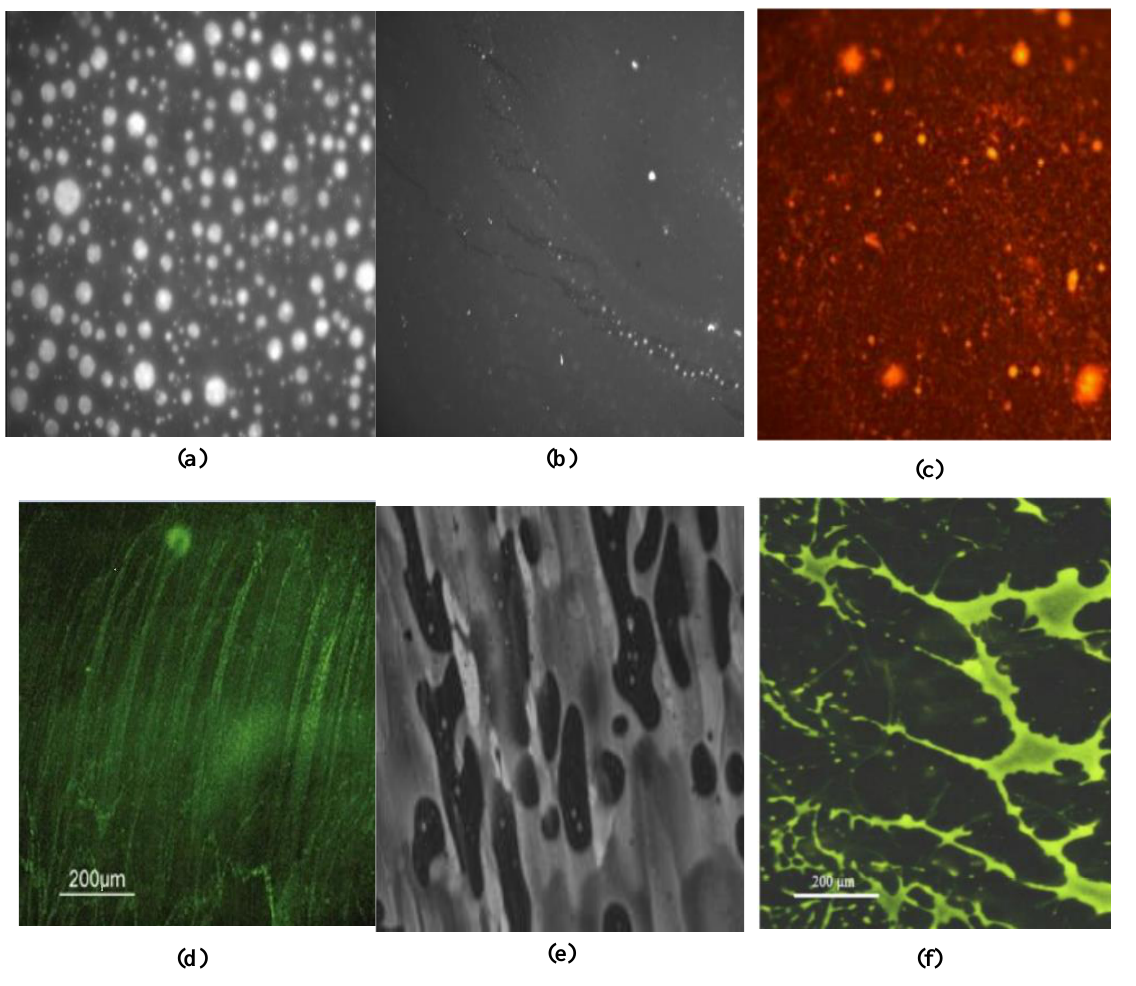
Figure 5. Fluorescence microscopic images of blends of asphalt with different types of waste plas- tics: ( a ) LDPE/asphalt [43]; ( b ) HDPE/asphalt [43]; ( c ) PP/asphalt [45]; ( d ) PVC/asphalt [46]; ( e ) EVA/asphalt [49]; ( f ) PS/asphalt [77]. Reprinted with permission from Refs.